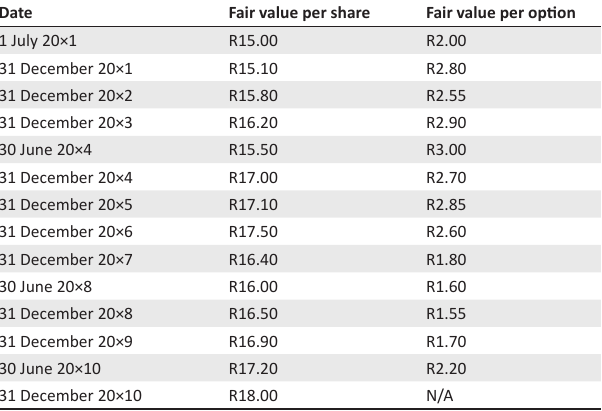
TABLE 6: Fair values of shares and options throughout the life of the